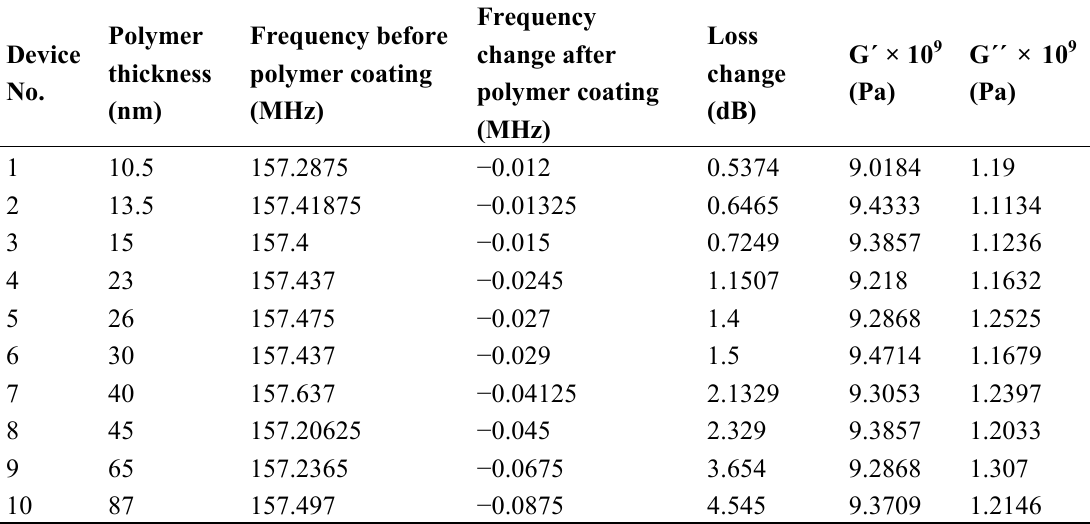
Table 1. The extraction of the shear modulus of the